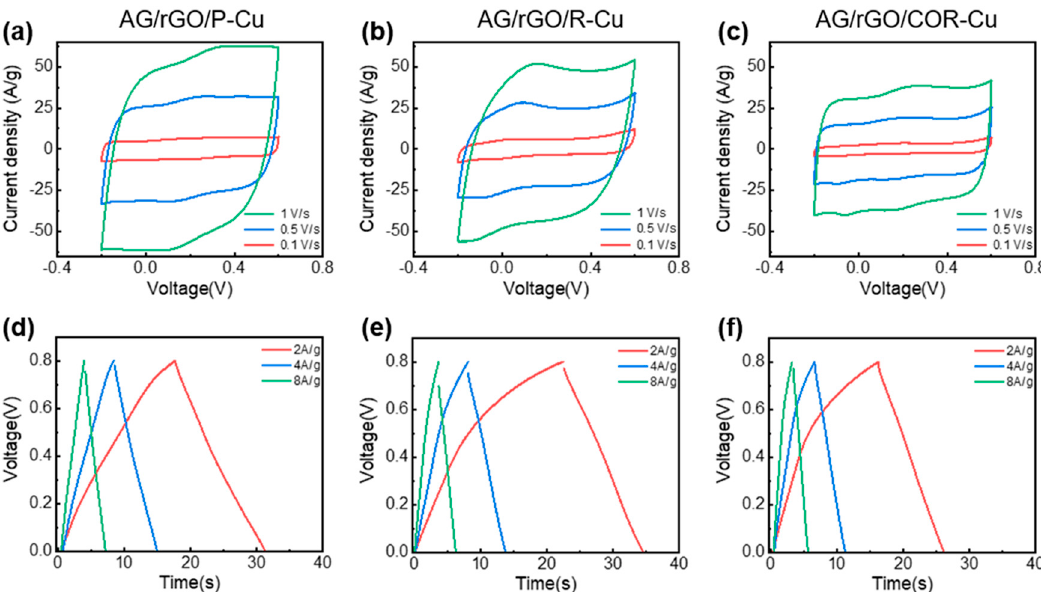
Figure 5. ( a – c ) CV curves of the supercapacitors using AG/rGO deposited on ( a ) P-Cu, ( b ) R-Cu, and ( c ) B-Cu mesh electrodes at scan rates of 0.1, 0.5, and 1 V/s. ( d – f ) GCD curves of the supercapacitors using AG/rGO deposited on ( d ) P-Cu, ( e ) R-Cu, and ( f ) B-Cu mesh electrodes at current densities of 2, 4, and 8 A/g.